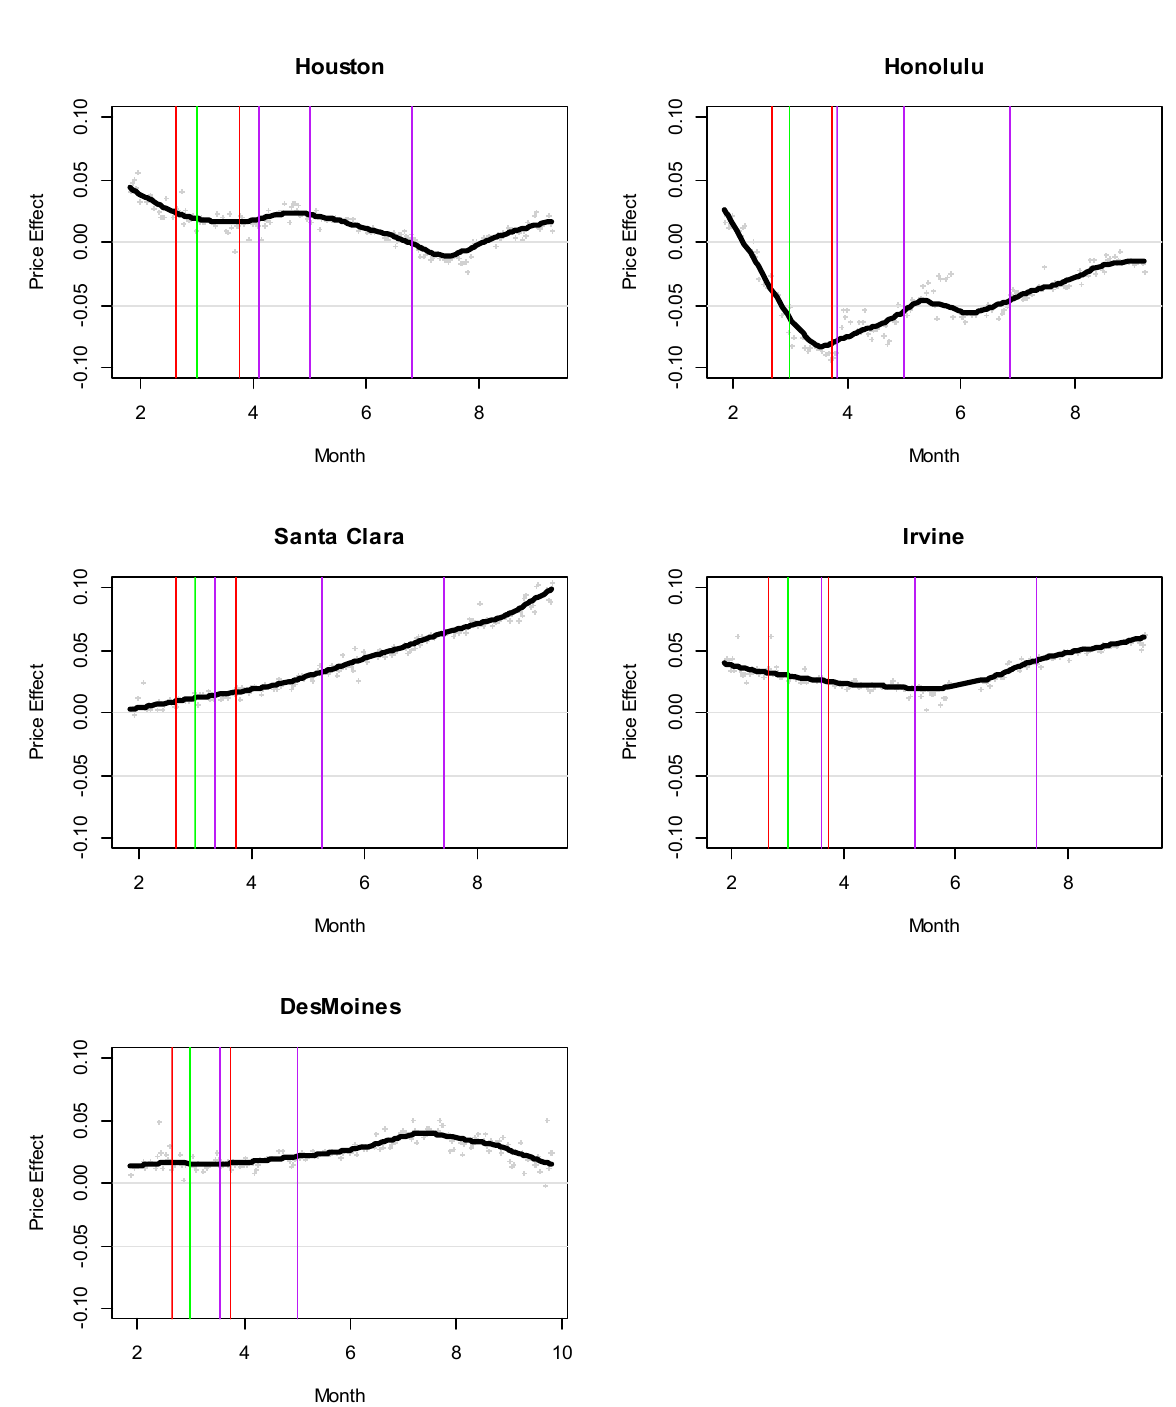
Figure 2. Effects of COVID-19 on House Prices. Note: the figures show the effect of COVID-19 on house prices. The horizontal axis is the month (February to September in 2020) when the transaction starts or when the offer is accepted and signed. The vertical axis is the price effect. An effect of 0.04 indicates that the house price increases by 4% as a result of the outbreak. The vertical lines colored red, green and red show the time points of when the stock price collapsed on 02/21/20, recovered on 03/23/20, and the interest rate fell on 03/01/20. The three purple vertical lines represent the start time of the stay home orders, the reopening of the economy and the reverse of the reopening.